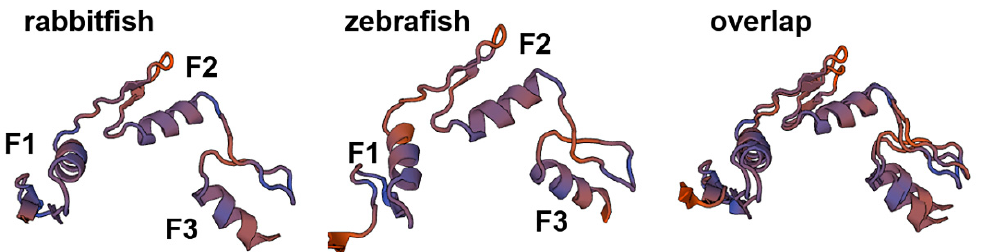
Figure 4. The predicted three-dimensional structures of the Sp1 protein DNA-binding zinc finger domains in the rabbitfish ( S. canaliculatus ) and zebrafish ( D. rerio ), and their overlap. The predicted domain structures were modeled using the on-line program SWISS-MODEL Automated Protein Modeling Mode (http://swissmodel.expasy.org/).